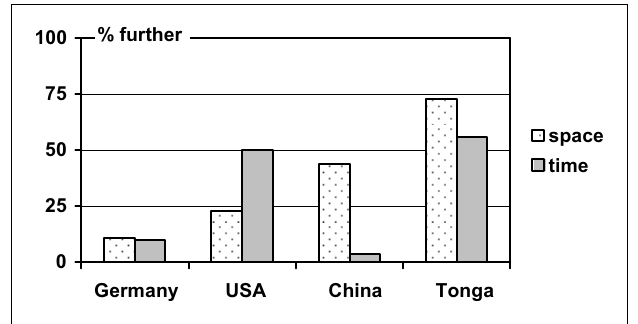
FIGURE 2 | Percentage of individuals assigning FRONT further away from the observer in space and time (cf.Table 3).